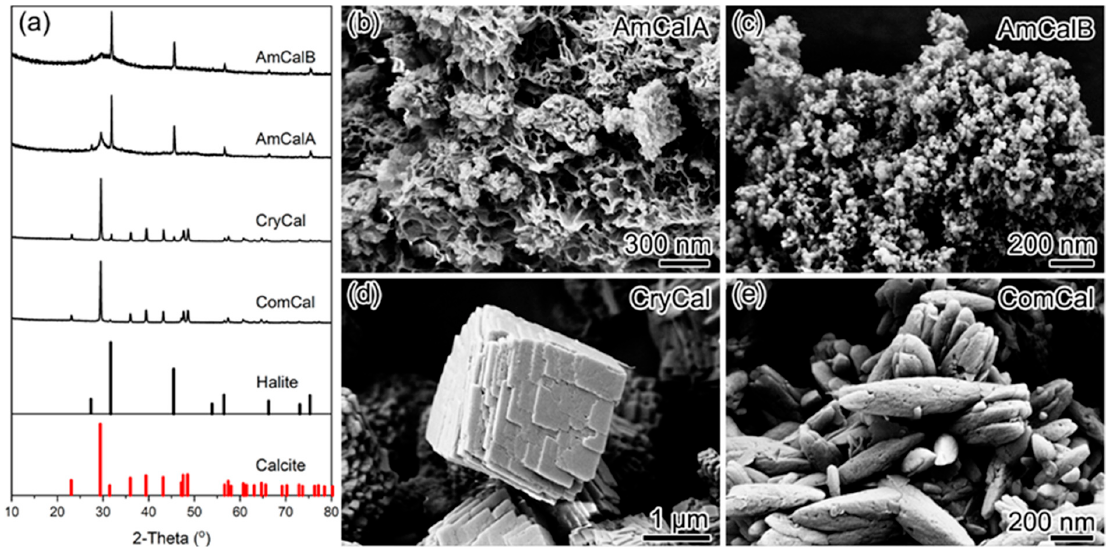
Figure 1. The powder XRD patterns ( a ) and the SEM images of varied CaCO 3 , ( b ) AmCalA, ( c ) Am- CalB, ( d ) CryCal, and ( e )